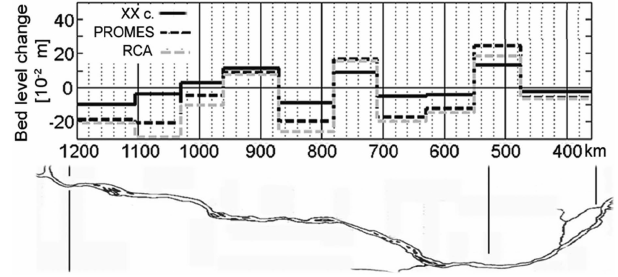
Figure 7. Simulated cumulate variation of the bed level for the continuous time series: past century and 21st century predictions (PROMES and RCA